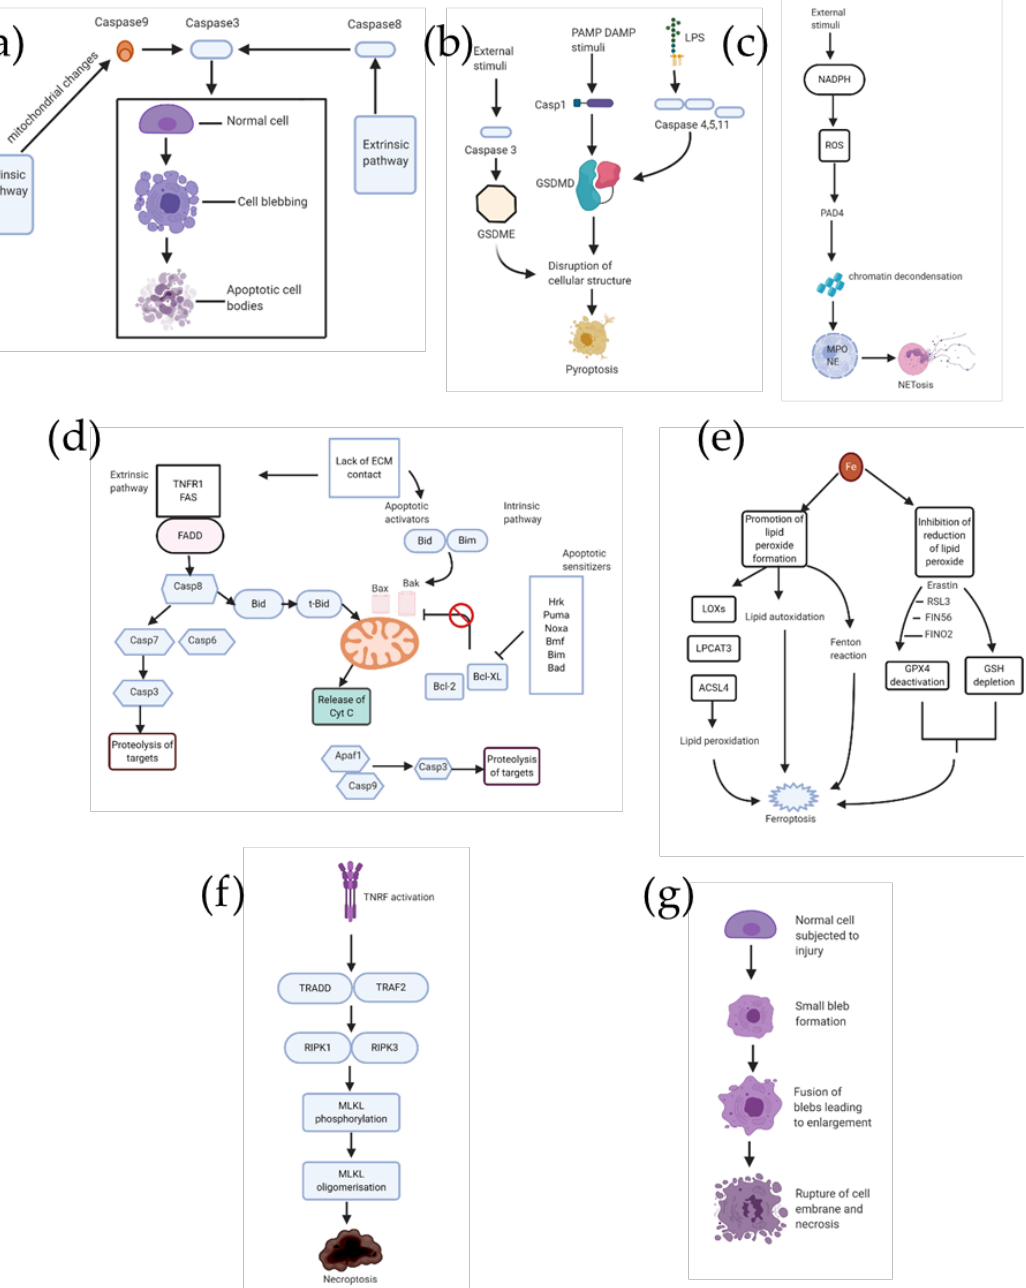
Figure 2. Schema for the mechanisms for di ff erent types of cell deaths. Part ( a ) displays two important pathways for apoptosis, namely intrinsic and extrinsic pathways, both converging at caspase-3 as the executioner pathway. Part ( b ) shows the three underlying pathways for pyroptosis involving caspases 1,3,4,5, and 11. Part ( c ) is the schematic representation for NETosis. Part ( d ) exhibits the two pathways for anoikis, intrinsic and extrinsic, respectively. Part ( e ) outlines the mechanistic pathways associated with ferroptosis, promotion of lipid peroxide formation being one path and inhibition of reduction of lipid peroxide being the other. TNF / TNFR signaling pathway for necroptosis via MLKL phosphorylation is displayed in part ( f ). Finally, part ( g ) represents the di ff erent stages in a general necrosis mechanism.